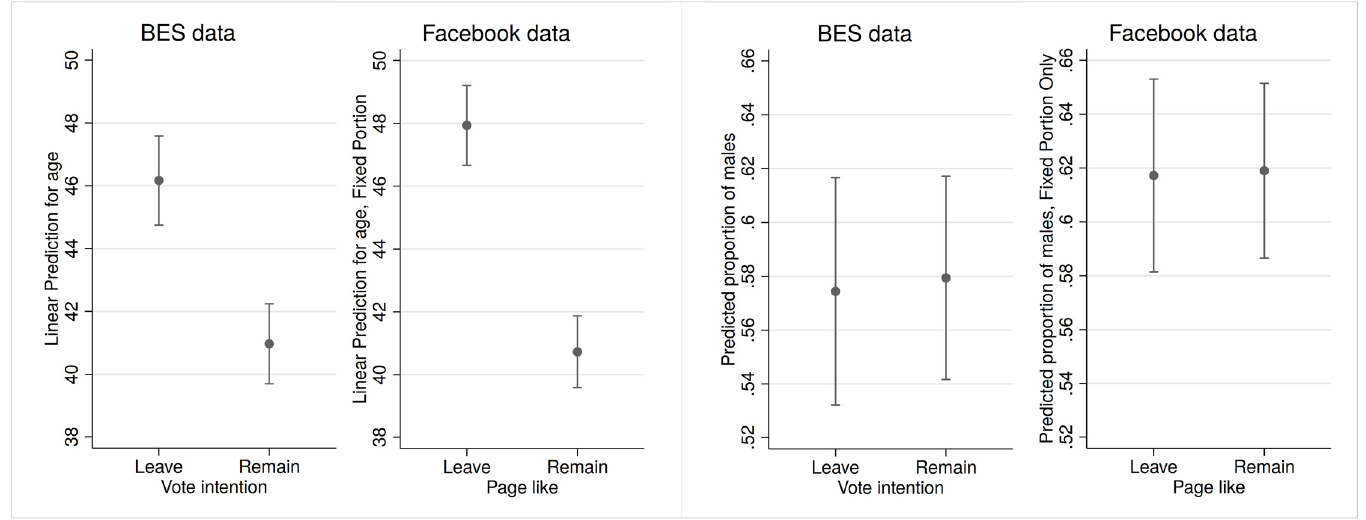
Fig 5. Average age (left panel) and gender proportions (right panel) in BES 2016 data and predicted by CNN model (Facebook data).